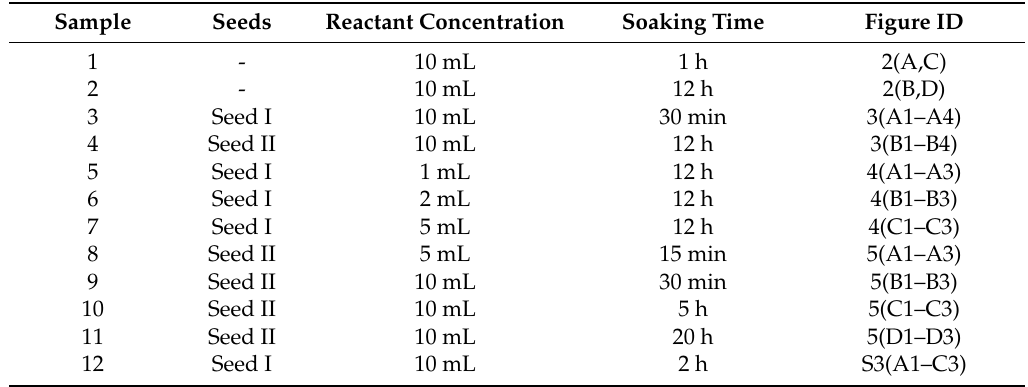
Table 1. Sample number and corresponding reaction conditions used to fabricate SERS-active substrates. Sample Seeds Reactant Concentration Soaking Time Figure